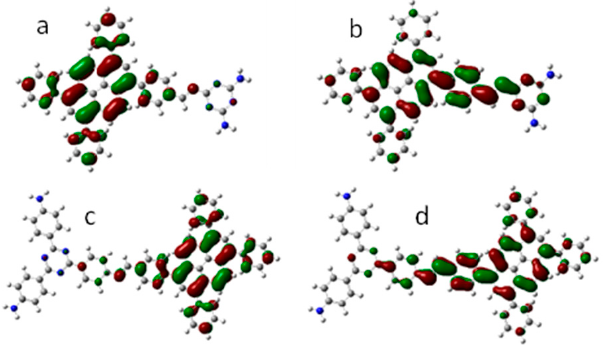
Figure 11. HOMO orbitals for ( a ) CP-shu-1 and ( c ) CP-shu-2 and LUMO orbitals for ( b ) CP-shu-1 and ( d ) CP-shu-2.